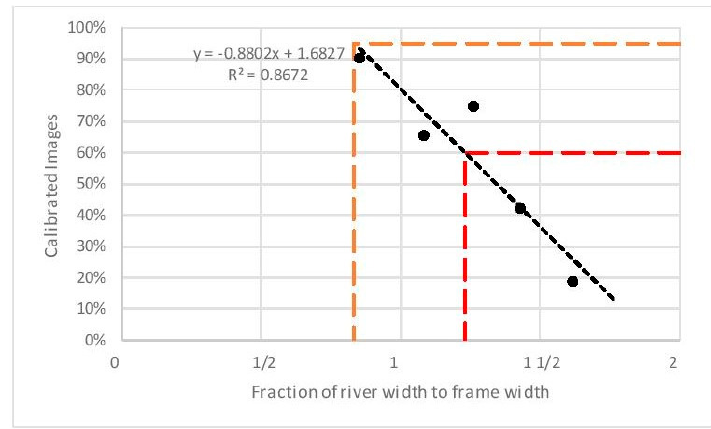
Figure A4. Relationship between calibrated images during Pix4D Mapper processing and the associated fractional value of river width to ground area covered by a TIR image. Acceptable SfM outputs require at least 60% calibrated images, the best fit line suggests that scenes in which the river width is 123% or more of the ground area covered by a TIR image cannot be rendered using sUAS thermal imagery.